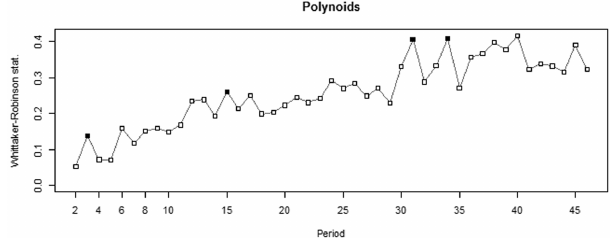
Figure A1. MAR faunal periodogram on polynoid densities with a 6h frequency (1 period on x axis is equal to 6h) of 23 days; all other taxa had no significant periodicities and were thus not shown. Black squares indicate periods significant at the 5% level.